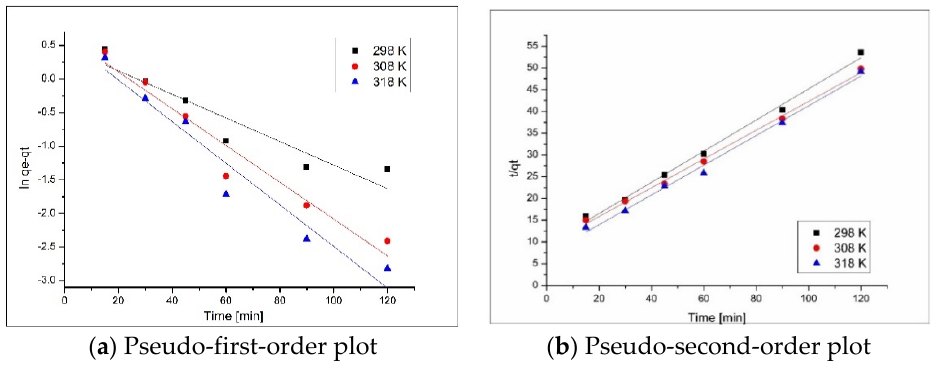
Figure 7. Kinetic models for Cd(II) adsorption onto Ch-HDTACl, at different temperatures.